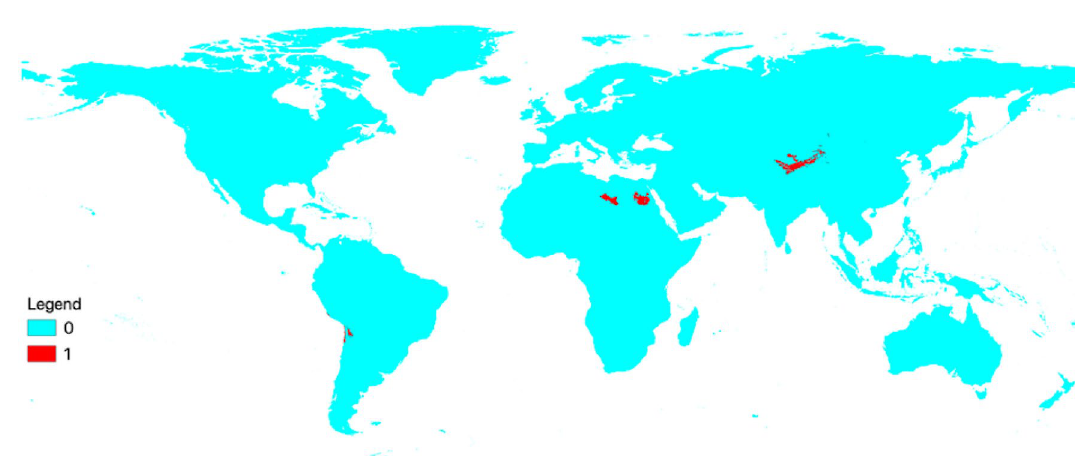
Figure 4. Model uncertainty measurement with a clamping mask value. The warmer color indicates areas where the model was uncertain, while blue colors depict the model’s prediction was